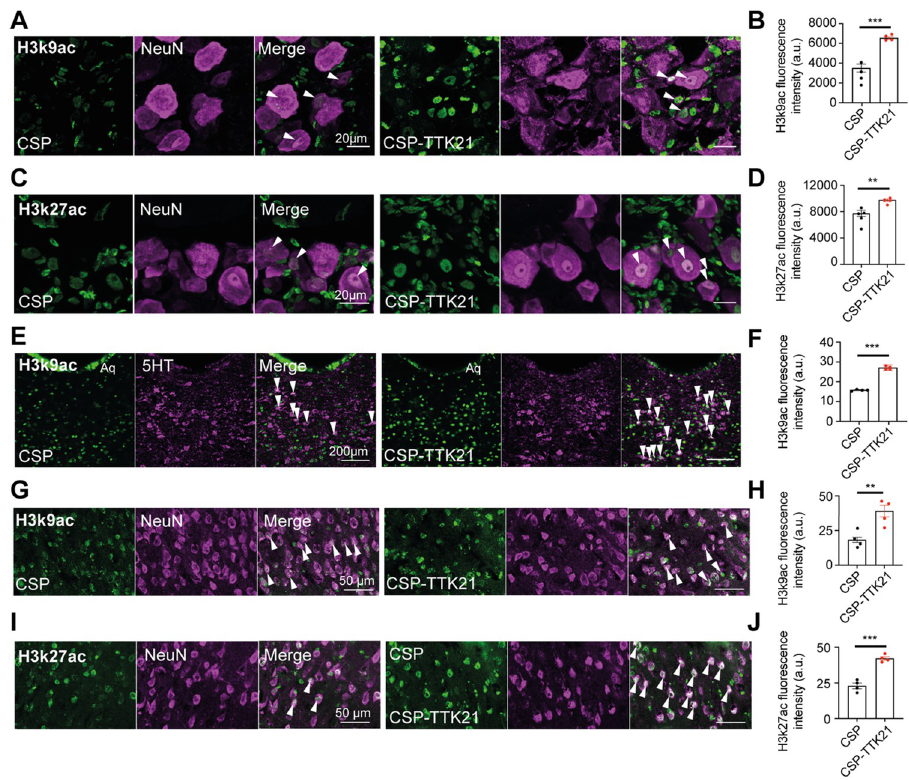
Fig 1. Histone acetylation in DRG, raphe, and layer 5 cortical neurons in CSP-TTK21-treated mice in a chronic SCI with severe disability. (A) Representative micrographs of H3K9ac immunostaining (green, white arrows) in DRG neurons. ( B) Quantification of H3K9ac immunostaining in DRG neurons from CSP or CSP-TTK21-treated mice (CSP: 3,505.0 ± 399.8; CSP-TTK21: 6,549.0 ± 122.1, p < 0.001, n = 4). ( C) Representative micrographs of H3K27ac immunostaining (green, white arrows) in DRG neurons. ( D) Quantification of H3K27ac immunostaining in DRG neurons in CSP or CSP-TTK21-treated mice (CSP: 7,738.0 ± 472.0, n = 5; CSP-TTK21: 9,779.0 ± 195.4, p < 0.01, n = 4). ( E) Representative micrographs of H3K9ac staining (green, white arrows) in raphe neurons. ( F) Quantification of H3K27ac immunostaining in raphe neurons from CSP or CSP-TTK21-treated mice (CSP: 15.9 ± 0.2; CSP-TTK21: 27.1 ± 1.4, p < 0.001, n = 4). ( G) Representative micrographs of H3K9ac immunostaining (green, white arrows) in layer 5 cortical neurons. ( H) Quantification of H3K9ac immunostaining in layer 5 cortical neurons from CSP or CSP-TTK21-treated mice (CSP: 18.2 ± 1.8; CSP-TTK21: 39.0 ± 4.1, p < 0.01, n = 4). ( I) Representative micrographs of H3K27ac staining (green, white arrows) in layer 5 cortical neurons. (J) Quantification of H3K27ac immunostaining in layer 5 cortical neurons from CSP or CSP-TTK21-treated mice (CSP: 22.9 ± 2.9; CSP-TTK21: 42.1 ± 1.3, p < 0.001, n = 4). Mean ± SEM; unpaired two-tailed Student t test; �� p < 0.01, ��� p < 0.001. n = biologically independent animals. The data can be found in S1 Data. CSP AU : AbbreviationlistshavebeencompiledforthoseusedinFigs 1 (cid:0) 4 : Pleaseverifythatallentriesarecorrect : , carbon nanosphere; DRG, dorsal root ganglion; SCI, spinal cord